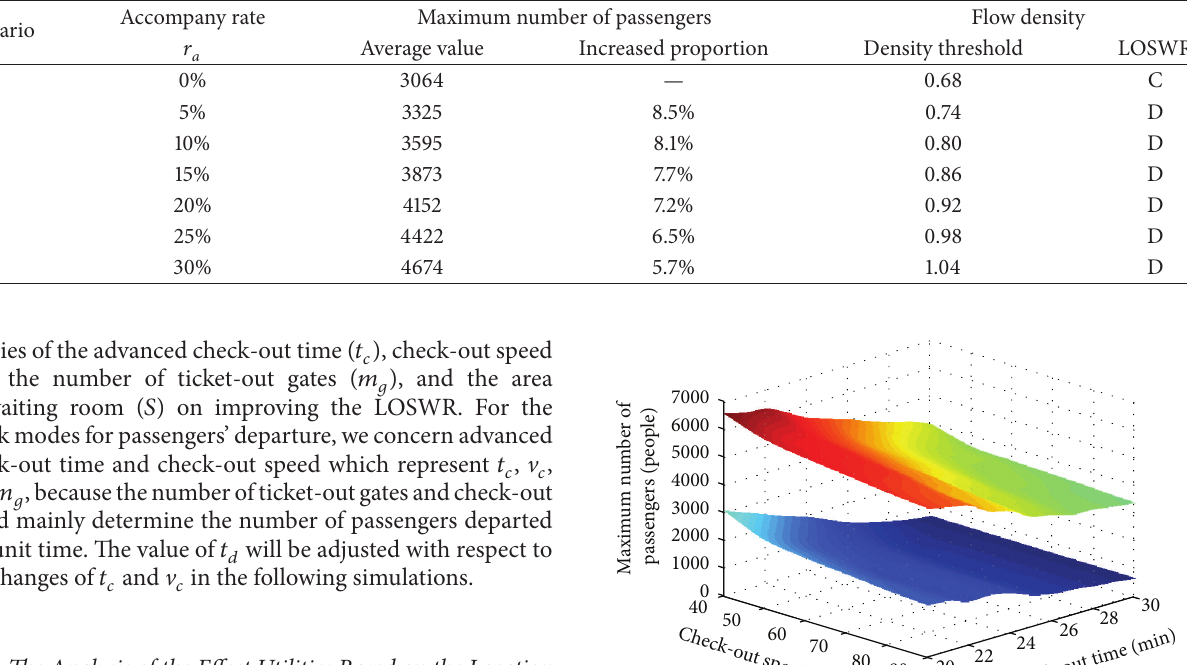
Table 8: The simulation results of railway passenger station waiting room ( 𝑟 𝑎 ).